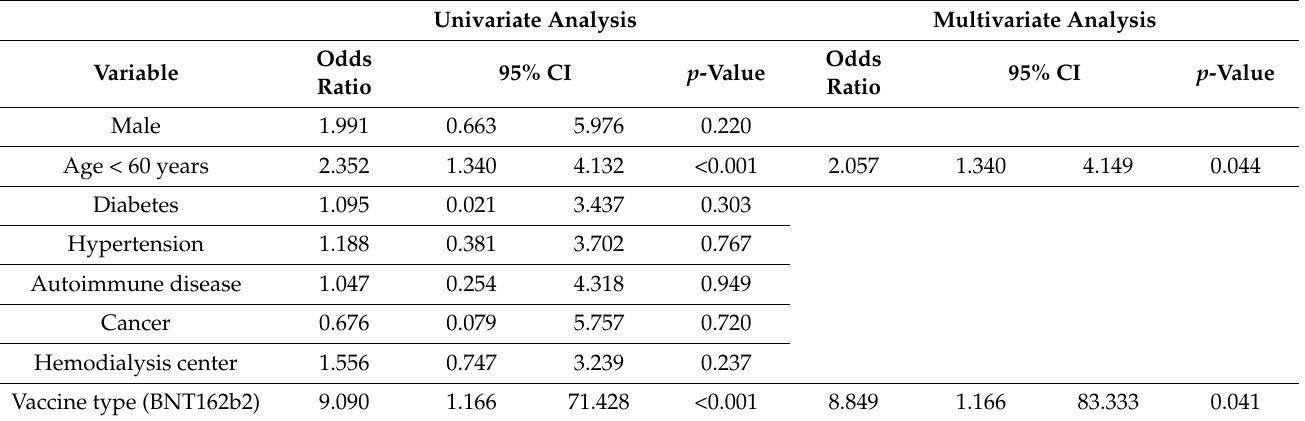
Table 4. Evaluation of predictors of vaccine responsiveness 4 months after the booster vaccination dose. Univariate and multivariate logistic regression of demographic, clinical, and laboratory param- eters of patients. Variables included in the multivariate model were those with a p -value below 0.1 in the univariate analysis. Variables considered as predictors of vaccine effectiveness were those with a p- value below 0.05 in the multivariate model. Odds ratios and their 95% confidence intervals (95% CI) and p -values are